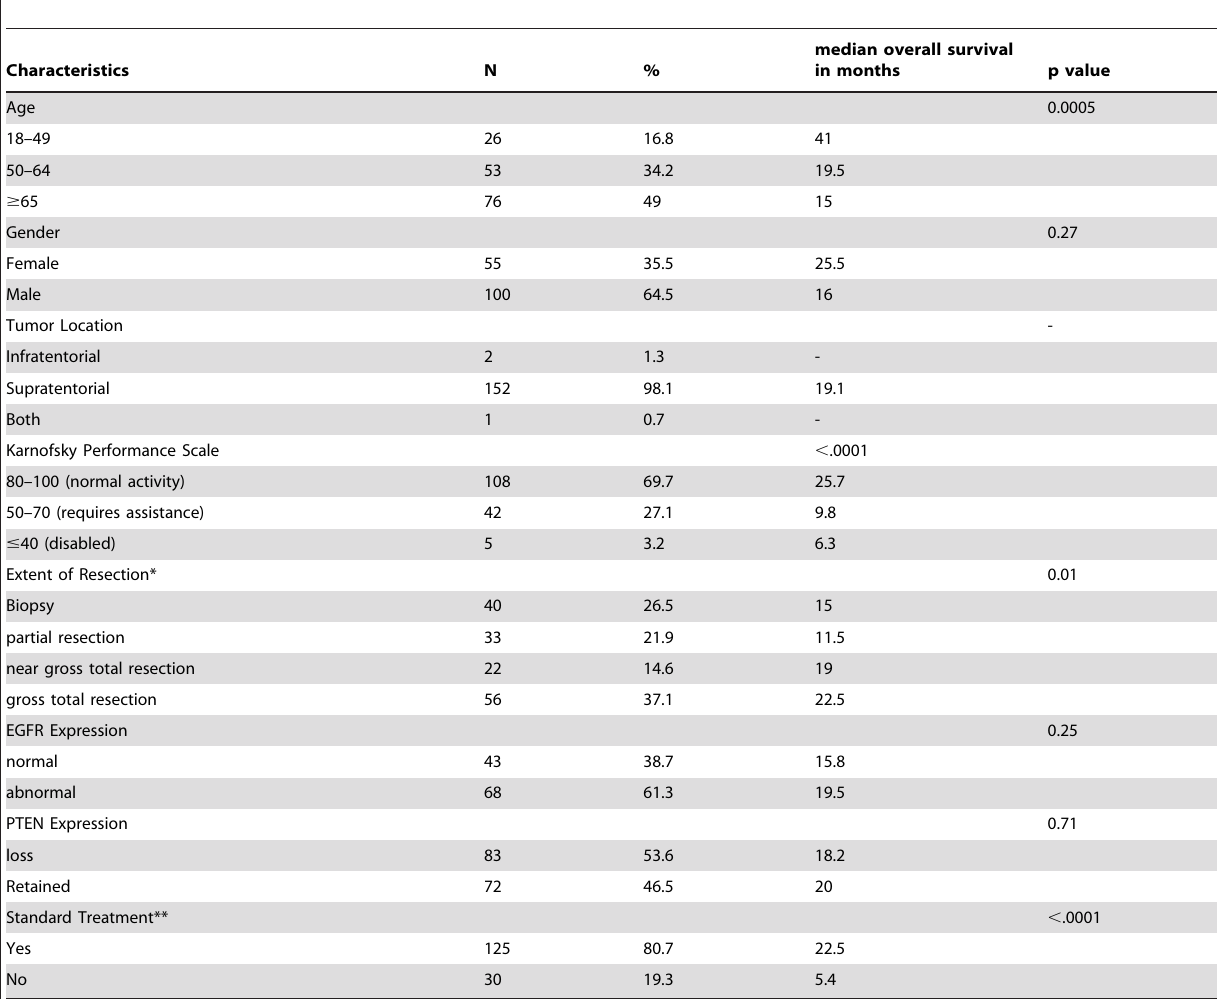
Table 2. Median overall survival by patient and tumor